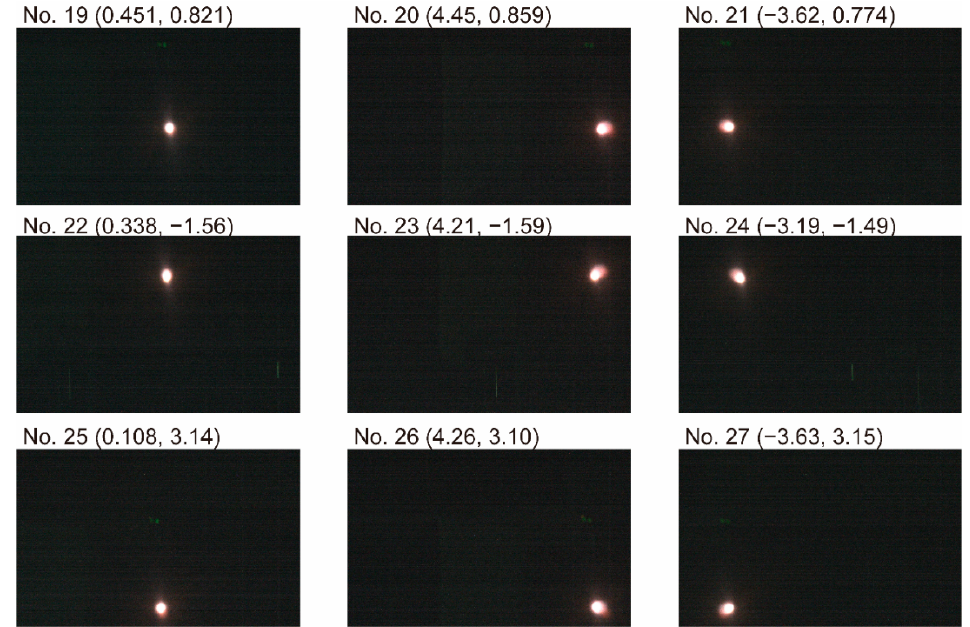
Figure A6. Captured color images of the light source at 2 m from the hybrid lens.